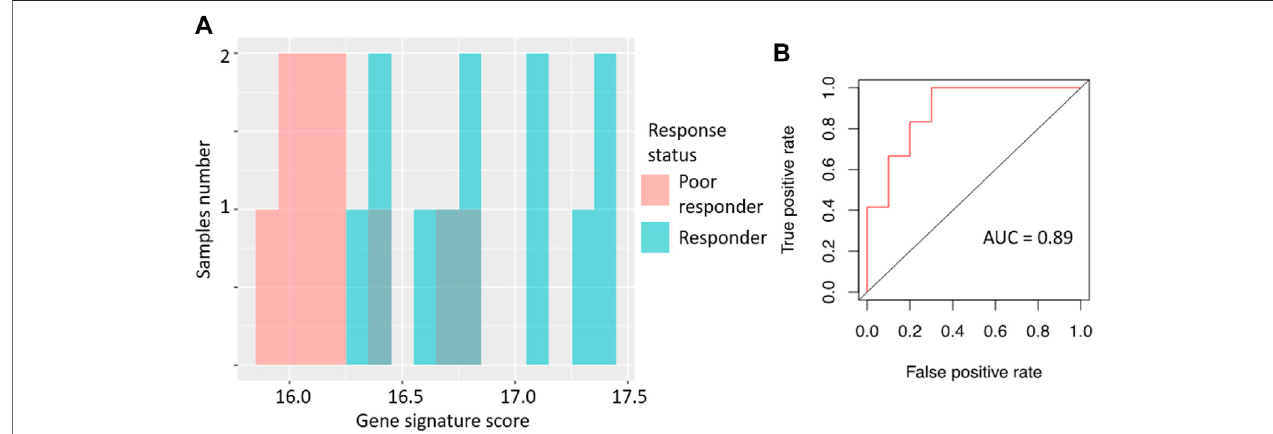
FIGURE2| Performanceofsorafenibresponse genesignatureinmicroarray-pro fi ledRCCset. (A) Distributionofgenesignaturescorein22RCC samplespro fi led by expression microarrays. (B) ROC (receiver operating characteristic) curve for prediction of response status by gene signature score in 22 RCC samples pro fi led by expression microarrays. Validation of sorafenib response gene signature.